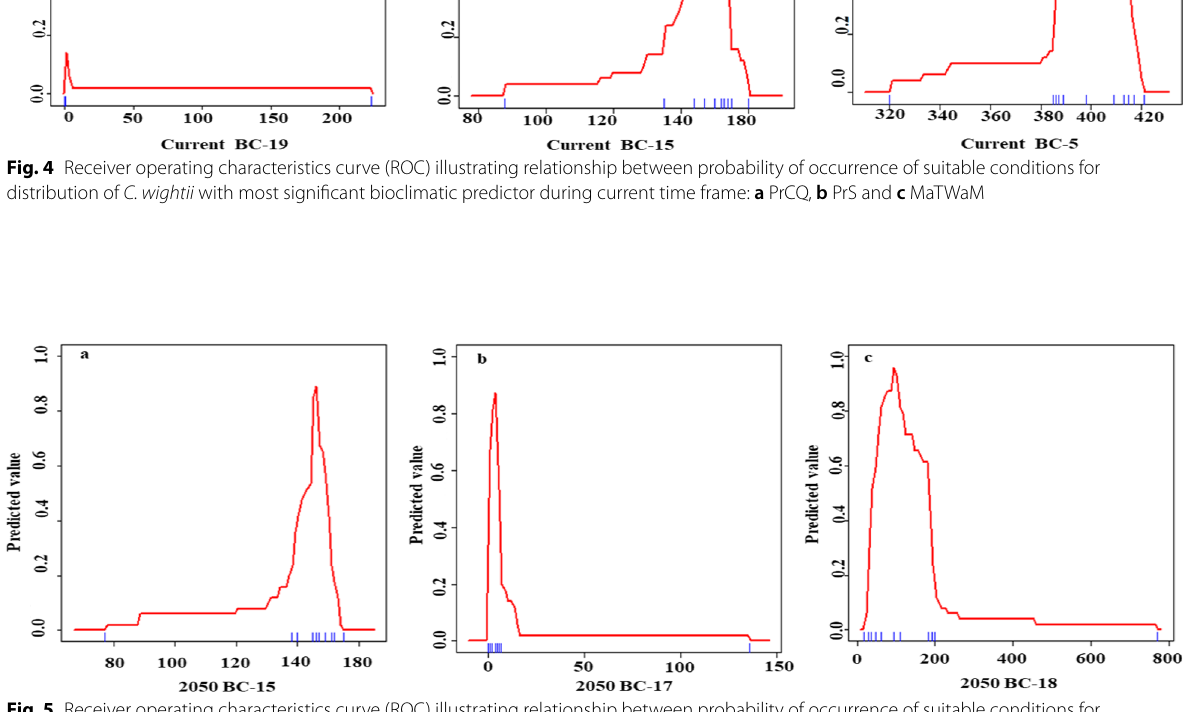
Fig. 5 Receiver operating characteristics curve (ROC) illustrating relationship between probability of occurrence of suitable conditions for distribution of C. wightii with most significant bioclimatic predictor during 2050 time frame: a PrS, b PrDQ and c PrWaQ